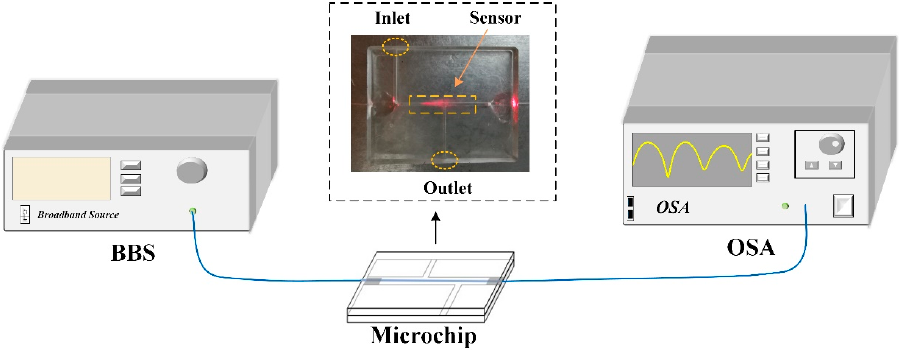
Figure 8. The experimental setup for Hb detection.